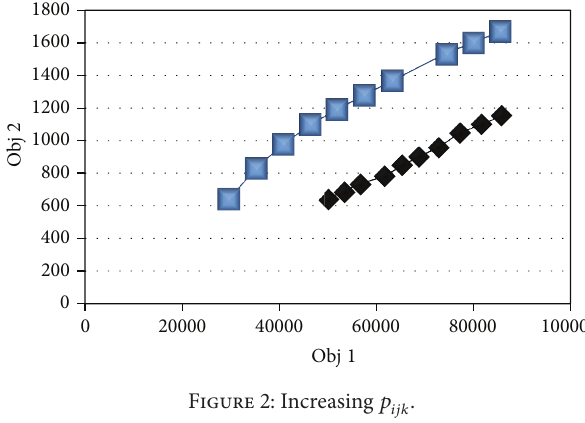
Figure 2: Increasing 𝑝 𝑖𝑗𝑘